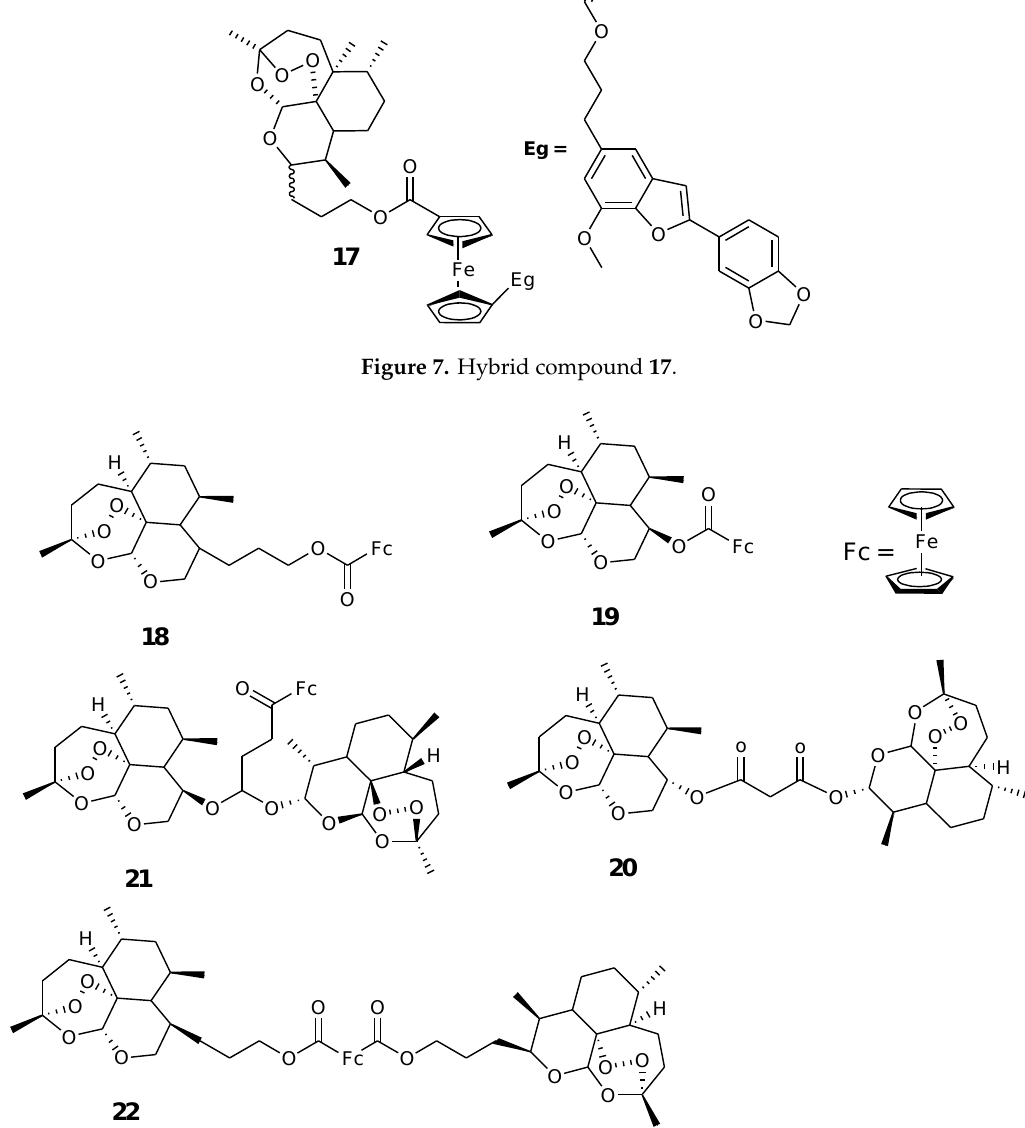
Figure 8. Chemical structures of second generation dihydroartemisinin ferrocene derivatives ( 18 – 22 ).